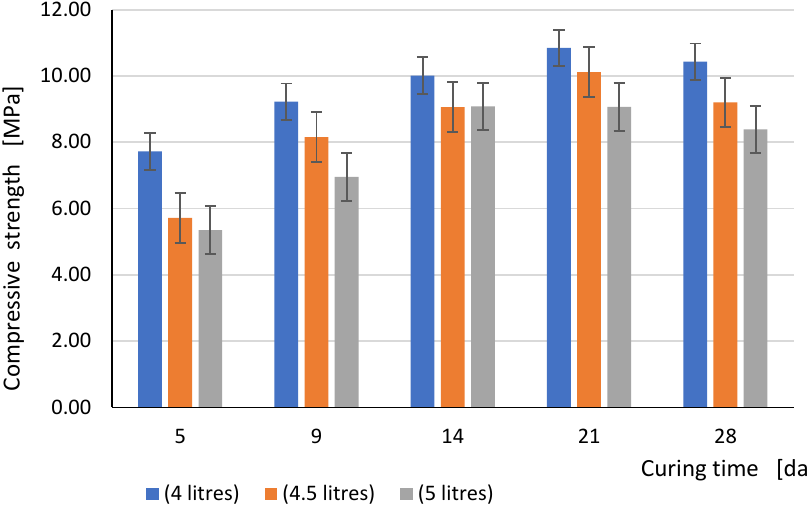
Figure 6. Compressive strength in dependence with the curing time (days) for all tested series.